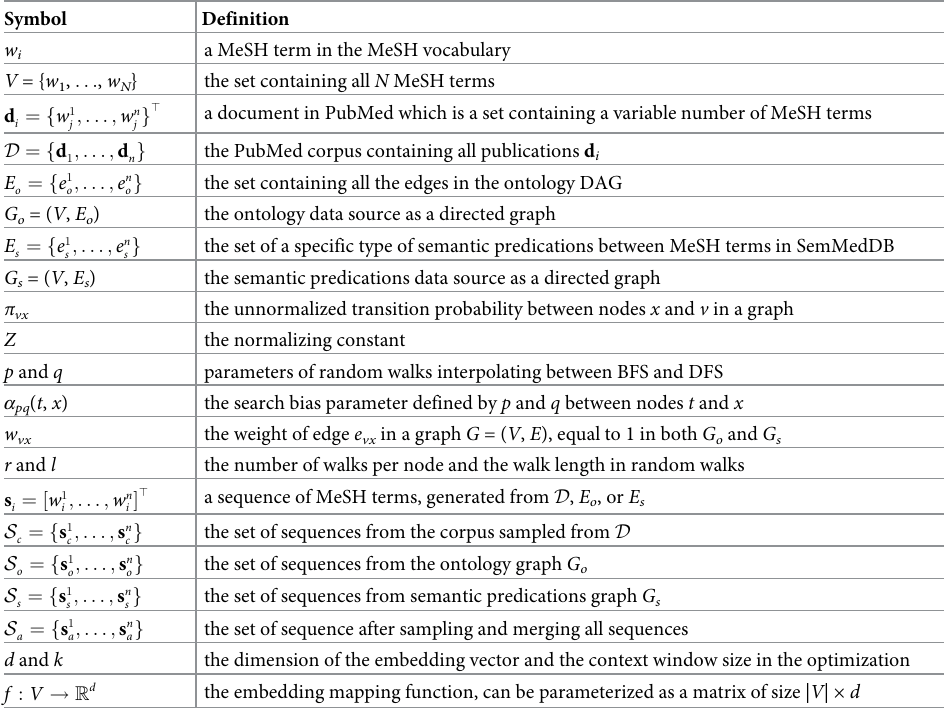
Table 2. Important